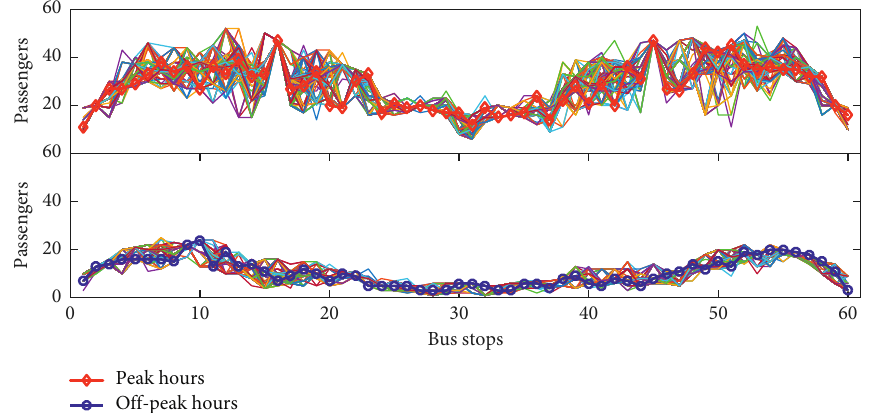
Figure 18: Generated passengers of each bus